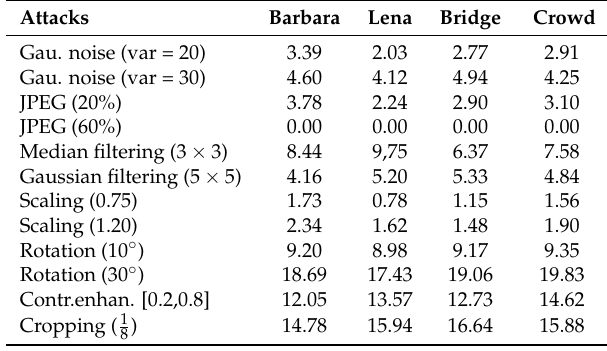
Table 3. BER (%) results of the extracted watermark under various attacks. Attacks Barbara Lena